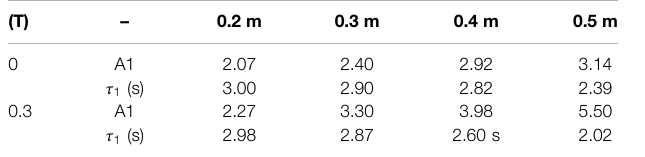
TABLE 2 | The fi tting results of Prony